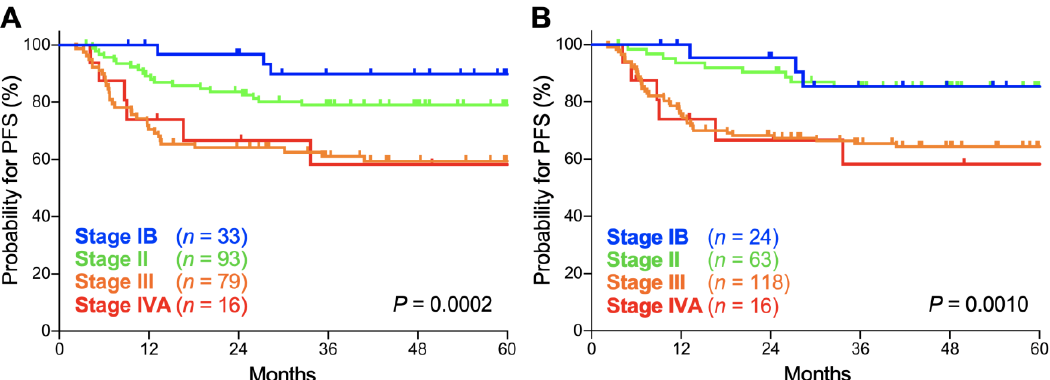
Figure 3. Kaplan–Meier estimates of progression-free survival (PFS) for patients with squamous cell carcinoma of the cervix according to the International Federation of Gynecology and Obstetrics (FIGO) 2009 ( A ) and 2018 ( B ) staging criteria. p values calculated from the log-rank test for trend are shown. Table 3. Five-year progression-free survival for the patients with squamous cell carcinoma of the uterine cervix according to the FIGO 2009 or FIGO 2018 schema. FIGO 2009 FIGO 2018